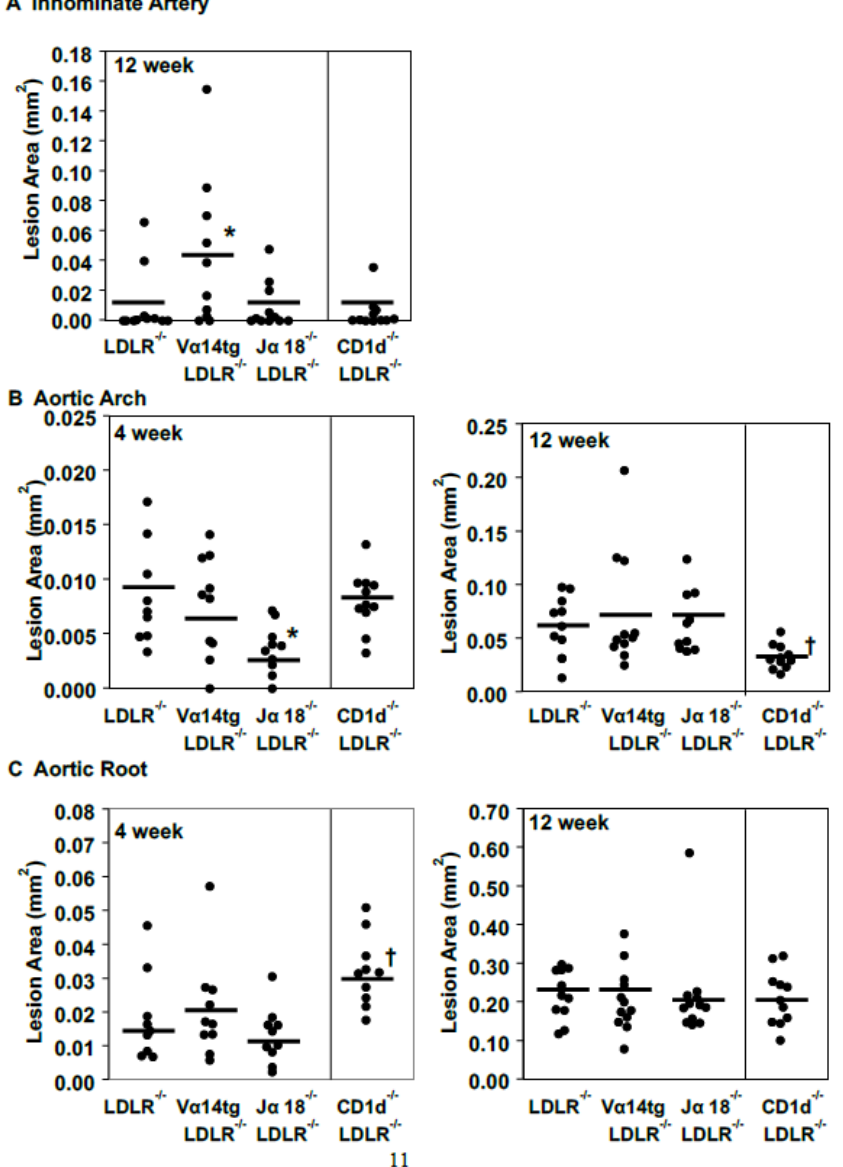
Figure 3. Atherosclerosis. Atherosclerosis was examined in the ( A ) innominate artery, ( B ) aortic arch, and ( C ) aortic root after 4 and 12 weeks on WTD. * Significant difference between Vα14tg/LDLR −/− or Jα18 −/− LDLR −/− and LDLR −/− mice. † Significant difference between Jα18 −/− LDLR −/− and CD1d −/− LDLR −/− mice.